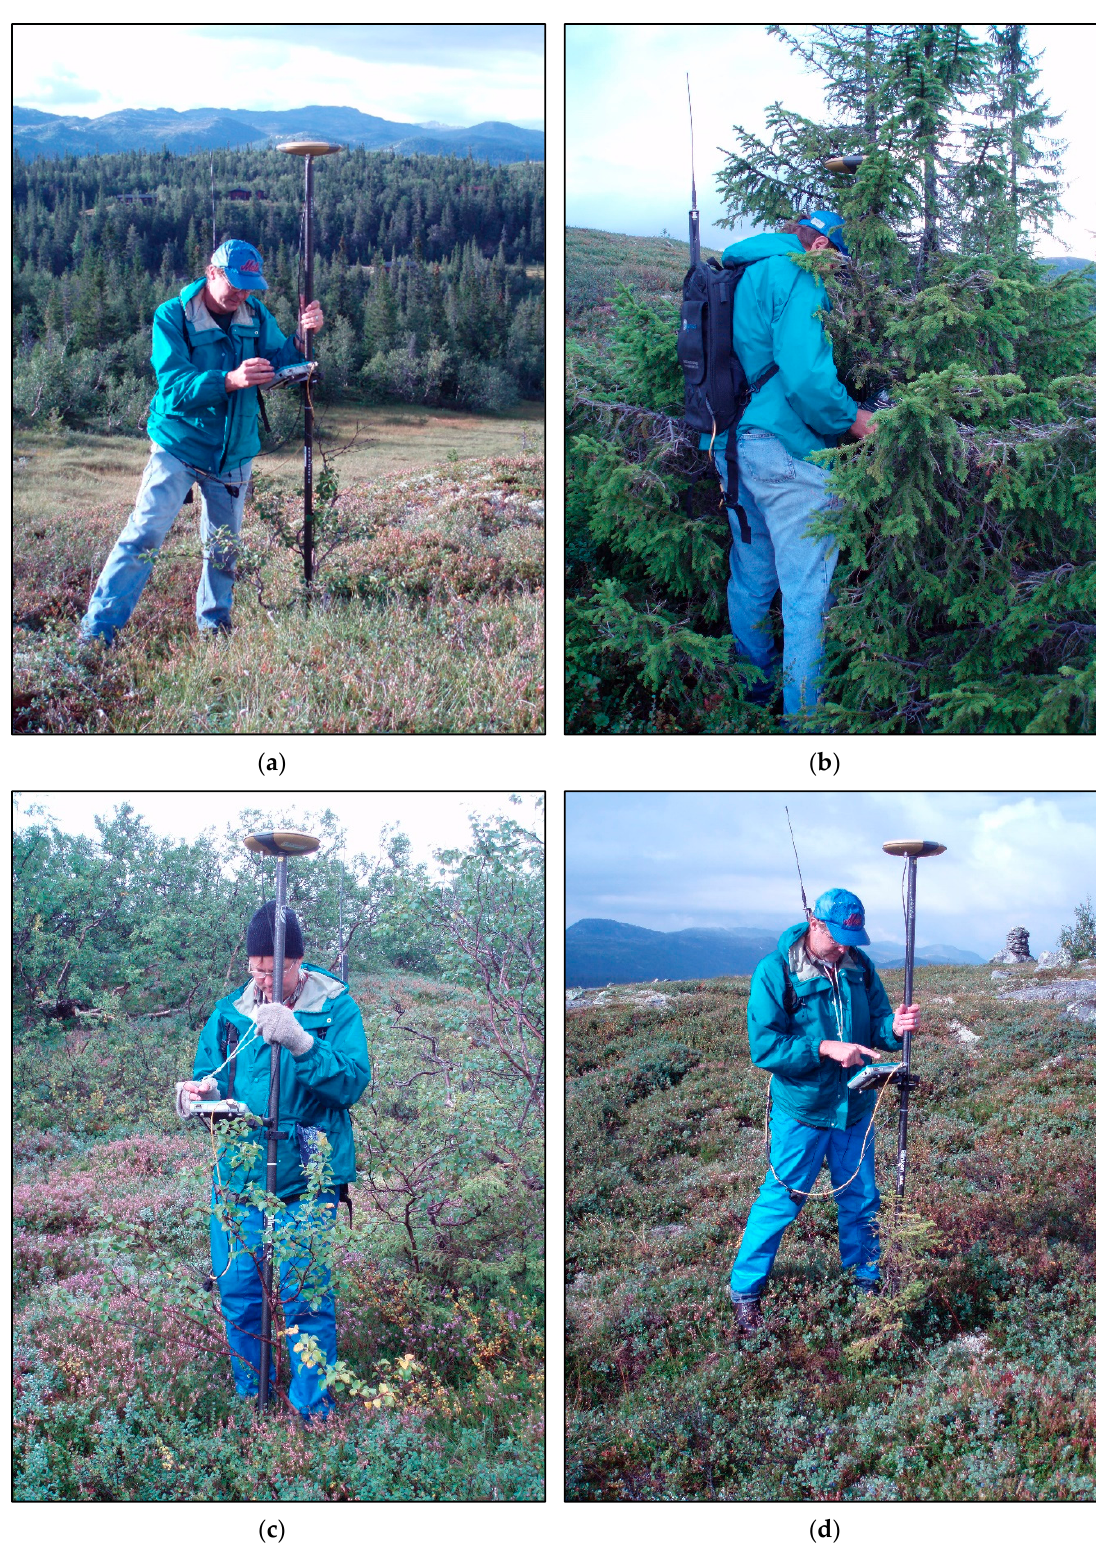
Figure 3. Tree measurements during field work in 2006. ( a ) Individual birch tree. ( b ) Group of spruce trees. ( c ) Groups of birch trees forming tall scrubby vegetation. ( d ) Individual spruce tree.